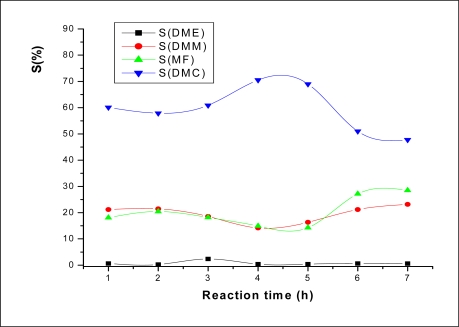
The effect of reaction time on product selectivity. Reaction conditions: m (catalyst) = 0.1 g; PCO2 = 2.5 bar.